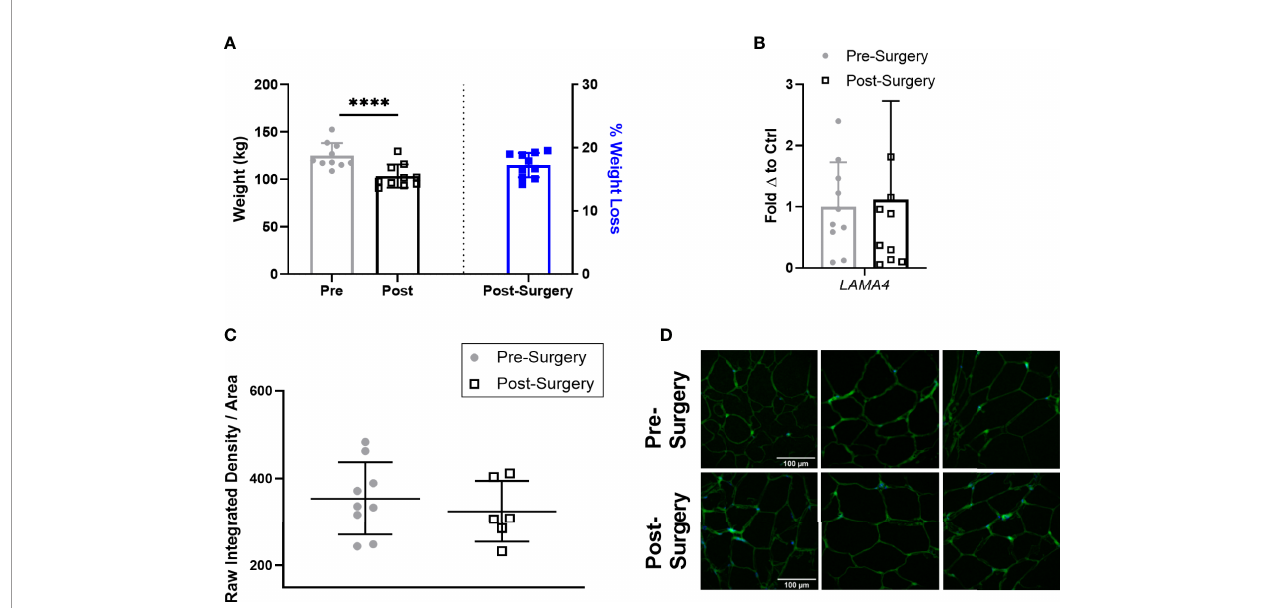
FIGURE 5 | LAMA4 expression does not change following short term weight loss in humans with obesity. (A) Weight (kg) of human subjects before and 3 months post-surgery shown on left y-axis [(****) indicates p < 0.0001] and % of weight loss 3 months post-surgery is shown on right y-axis. Data are Means ± SD. (B) LAMA4 mRNA expression in sWAT biopsies of obese subjects pre-surgery and 3 months post-surgery, normalized to average of pre-surgery subjects. Pre-surgery (n=9), Post-surgery (n=9). (C) Density of extracellular LAMA4 as determined by raw integrated density signal over total area of signal in fi xed sections of sWAT from obese subjects pre-surgery and 3 months post-surgery. Pre-surgery (n=9), Post-surgery (n=6). (D) Representative images of extracellular LAMA4 immuno fl uorescence staining from obese pre-surgery and post-surgery subjects. LAMA4 (in green) and DAPI (in blue). All images are 40X magni fi cation.